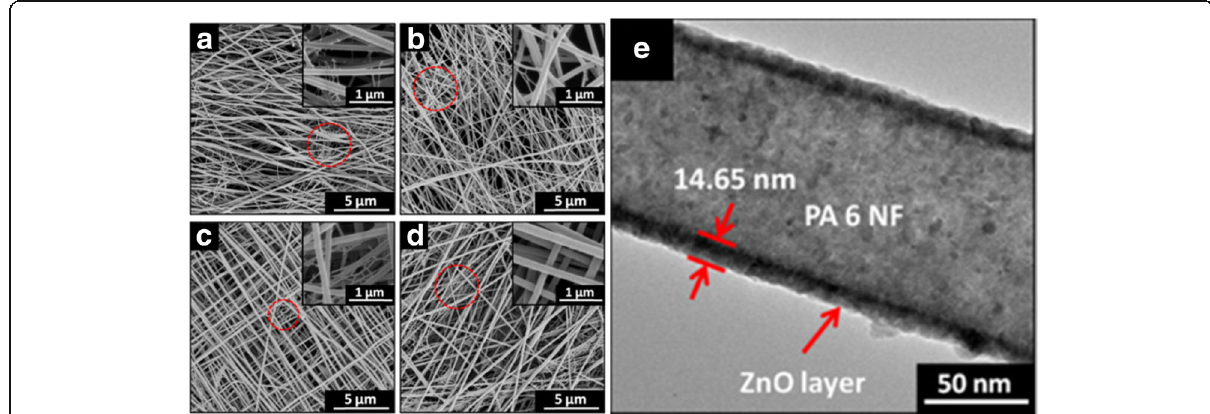
Fig. 1 FE-SEM images of a the as-spun PA 6 NFs. PA 6 NF coating by ALD ZnO at b 50, c 100, and d 150 cycles, respectively. e TEM image of the core-shell structure after 150 cycles of ALD ZnO coating